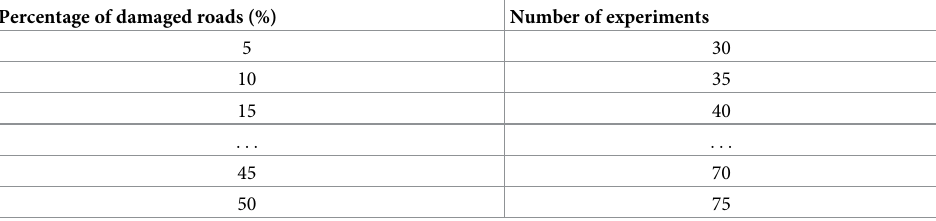
Table 3. Number of simulation